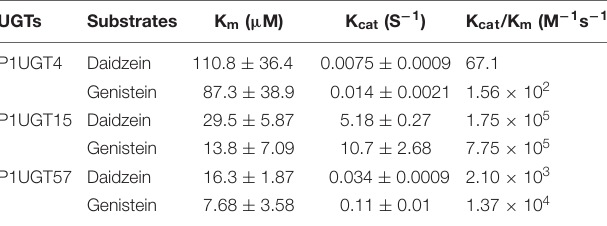
TABLE 1 | Kinetic parameters of three recombinant Pueraria lobata UDP-sugar-glucosyltransferases (PlUGT) toward isoflavonoid aglycones. UGTs